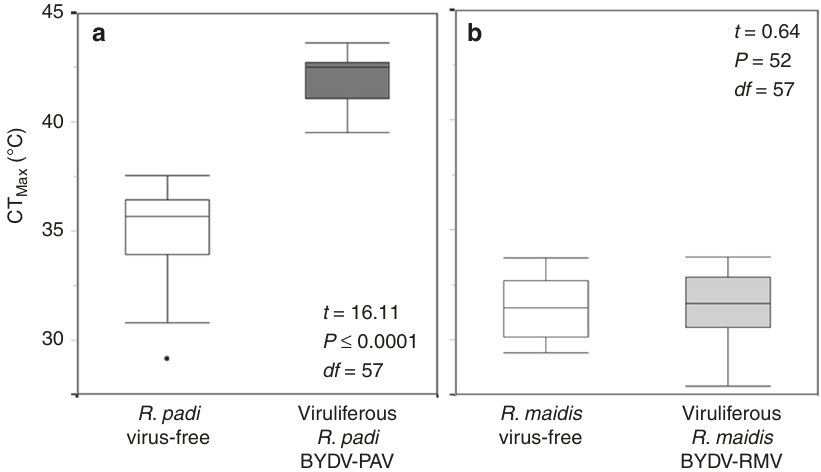
Fig. 3 Upper temperature limit for locomotion (CTMax) for viruliferous and virus-free aphid species. CT Max of ( a ) R. padi and ( b ) R. maidis . Student ’ s t test (boxplots display median line, interquartile range (IQR) boxes, 1.5 × IQR whiskers; n = 30 aphids per treatment). Source data are provided as a Source data fi